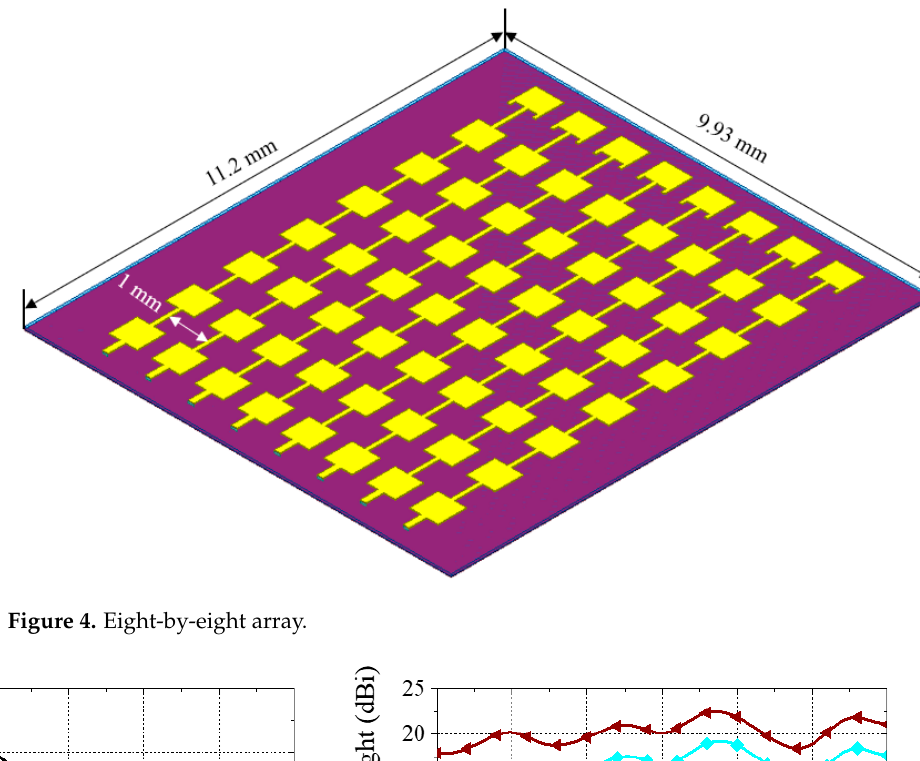
Figure 4. Eight-by-eight array.